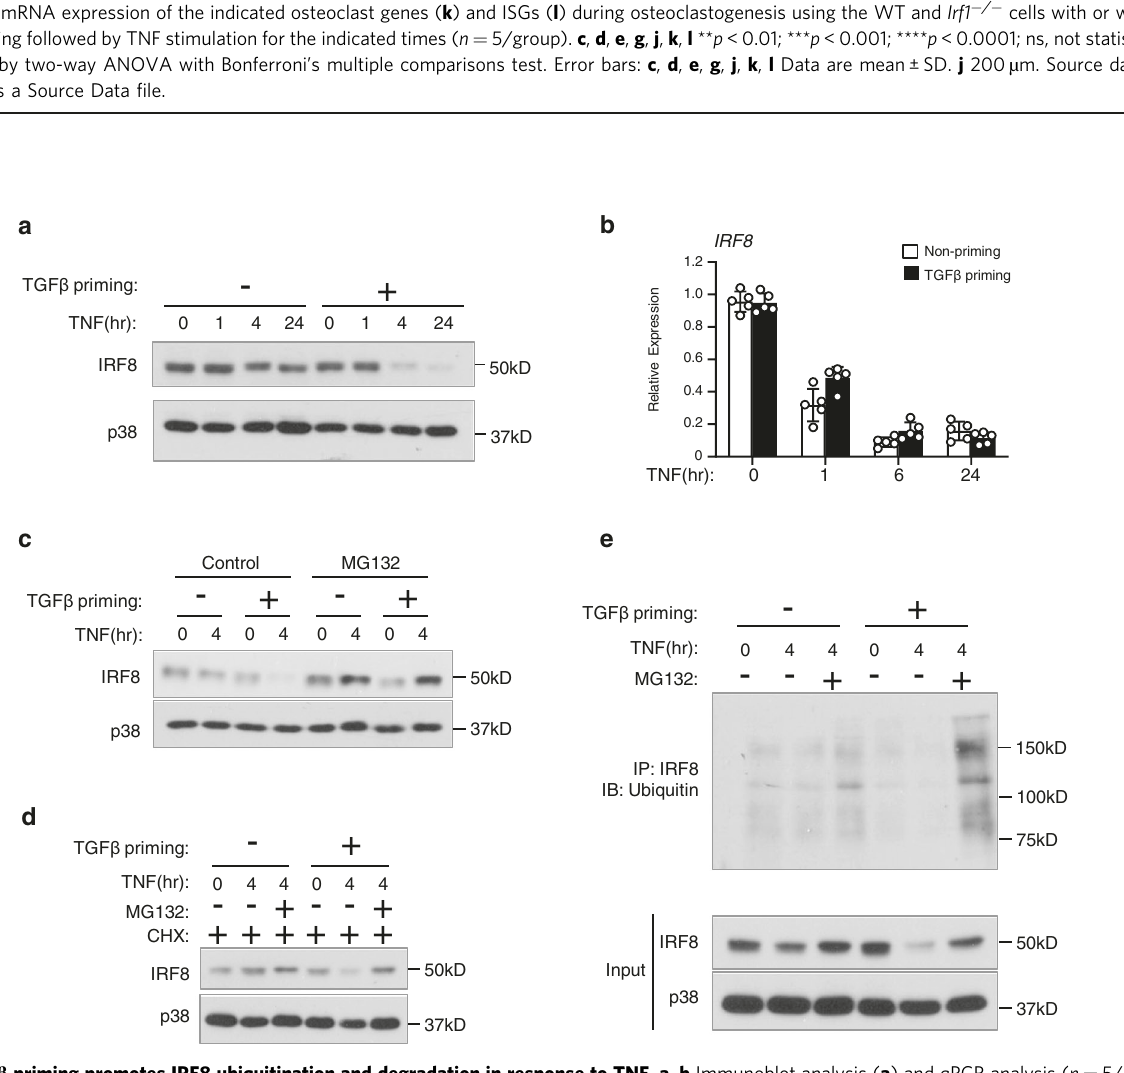
Fig. 6 TGF β priming promotes IRF8 ubiquitination and degradation in response to TNF. a , b Immunoblot analysis ( a ) and qPCR analysis ( n = 5/group) ( b ) of IRF8 expression using human CD14( + ) monocytes treated with or without TGF β priming for 3 days, followed by TNF stimulation at the indicated times. p38 was used as a loading control ( a ). c Immunoblot analysis of the expression of IRF8 using human CD14( + ) monocytes treated with or without TGF β priming for 3 days, followed by TNF stimulation together with DMSO or MG132 (25 µ M) for the indicated times. p38 was used as a loading control. d Immunoblot analysis of the expression of IRF8 using human CD14( + ) monocytes treated with or without TGF β priming for 3 days, then CHX (50 µ M) for 30 min, followed by TNF stimulation together with DMSO or MG132 (25 µ M) for the indicated times. p38 was used as a loading control. e Ubiquitination of IRF8 in the human CD14( + ) monocytes treated with or without TGF β priming for 3 days, followed by TNF stimulation together with DMSO or MG132 (25 µ M) for the indicated times. Cell lysates were immunoprecipitated with anti-IRF8 antibody followed by immunoblotting with anti-Ub antibody. IP, immunoprecipitation; IB, immunoblotting. b Data are mean ± SD. Source data are provided as a Source Data fi